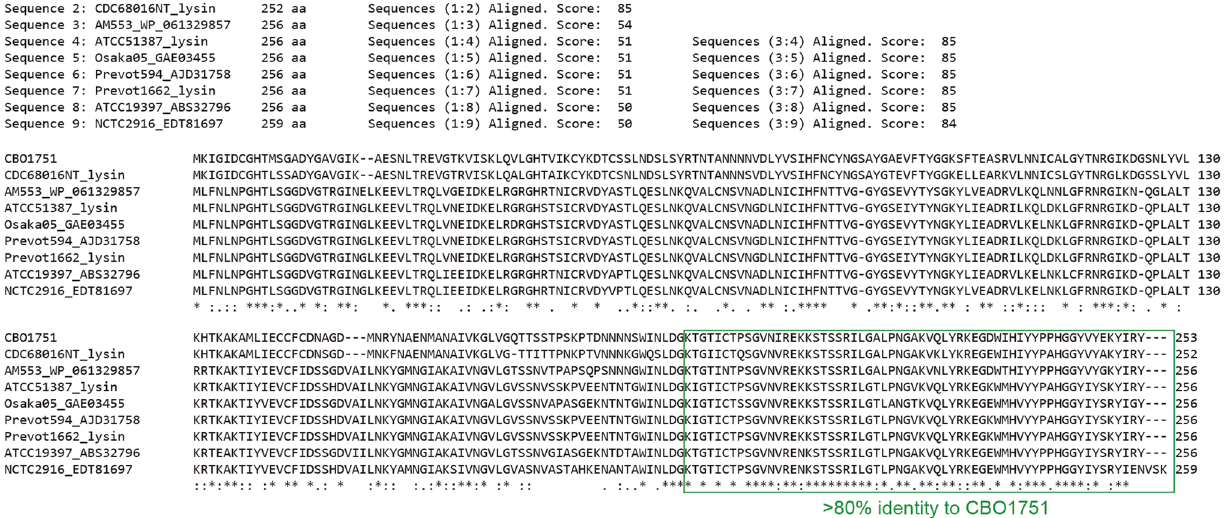
Figure 5. Amino acid sequence alignment of CBO1751 and putative lysins of Clostridium botulinum CDC68016NT (LAGL01000000, contig00983, nt 2654–3412), AM553 (WP_061329857), ATCC51387 (LAGD01000000, contig00030, nt 5143–5913), Osaka05 (GAE03455), Prevot594 (AJD31758), Prevot1662 (LAGM01000000, contig00035, nt 5087–5857), ATCC19397 (ABS32796) and NCTC2916 (EDT81697). Sequences encoding putative CBDs are indicated in a green